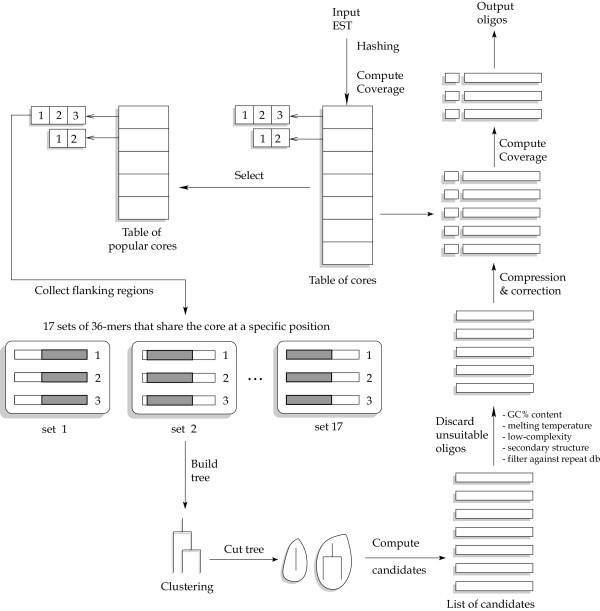
An overview of the algorithm for selecting popular oligos. The length of the oligos is assumed to be 36 bases, and the length of the cores is assumed to be 20 bases. Reproduced with permission from [24].